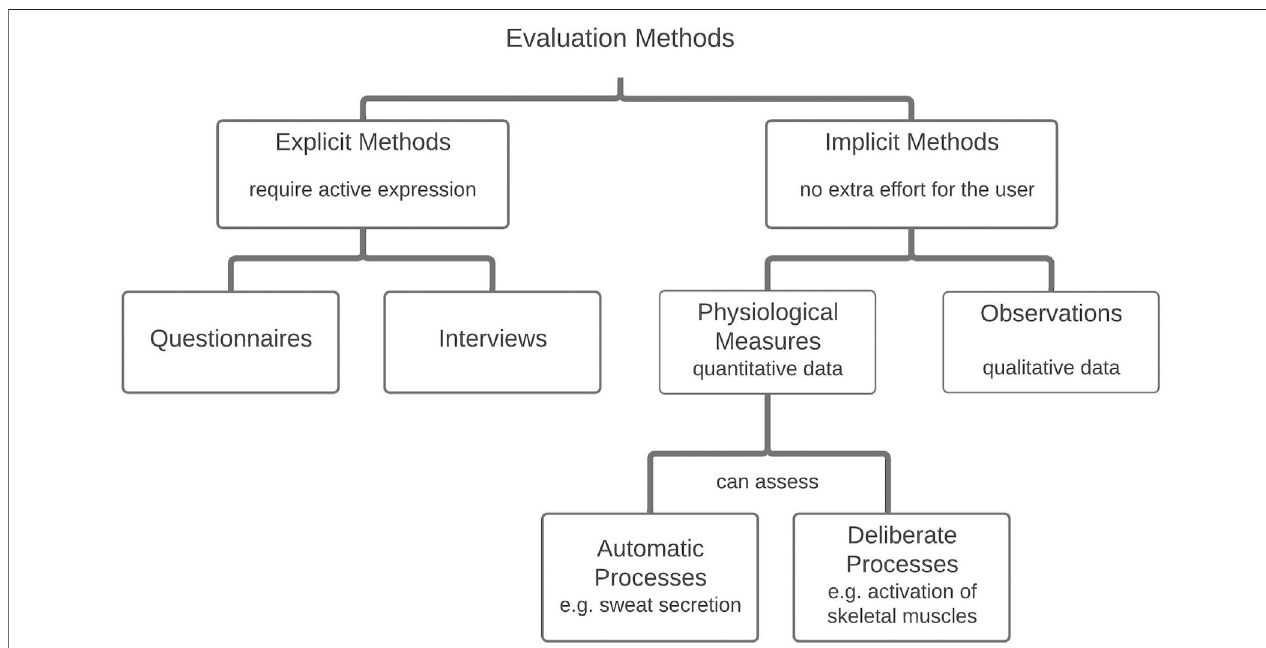
FIGURE 1 | Categorization of evaluation methods. The overview should not be considered comprehensive, but mereley as an orientation.